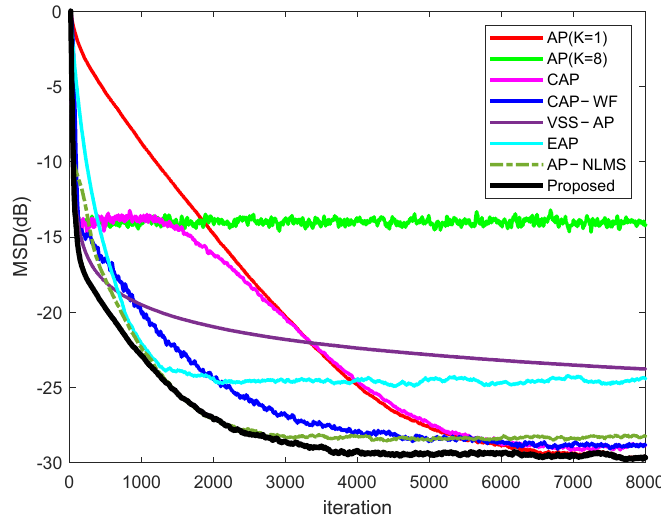
Figure 5. Convergence curves of the proposed algorithm and the conventional AP, CAP, CAP − WF, VSS − AP, EAP, and AP − NLMS algorithms in a stationary environment with SNR = 20 dB.